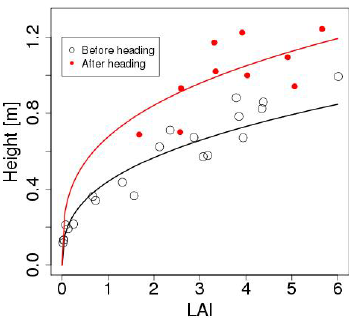
Figure 5. Relationship between specific leaf weight and develop- ment stage ( D vs ). A red curve denotes the fitted curve used in the model.